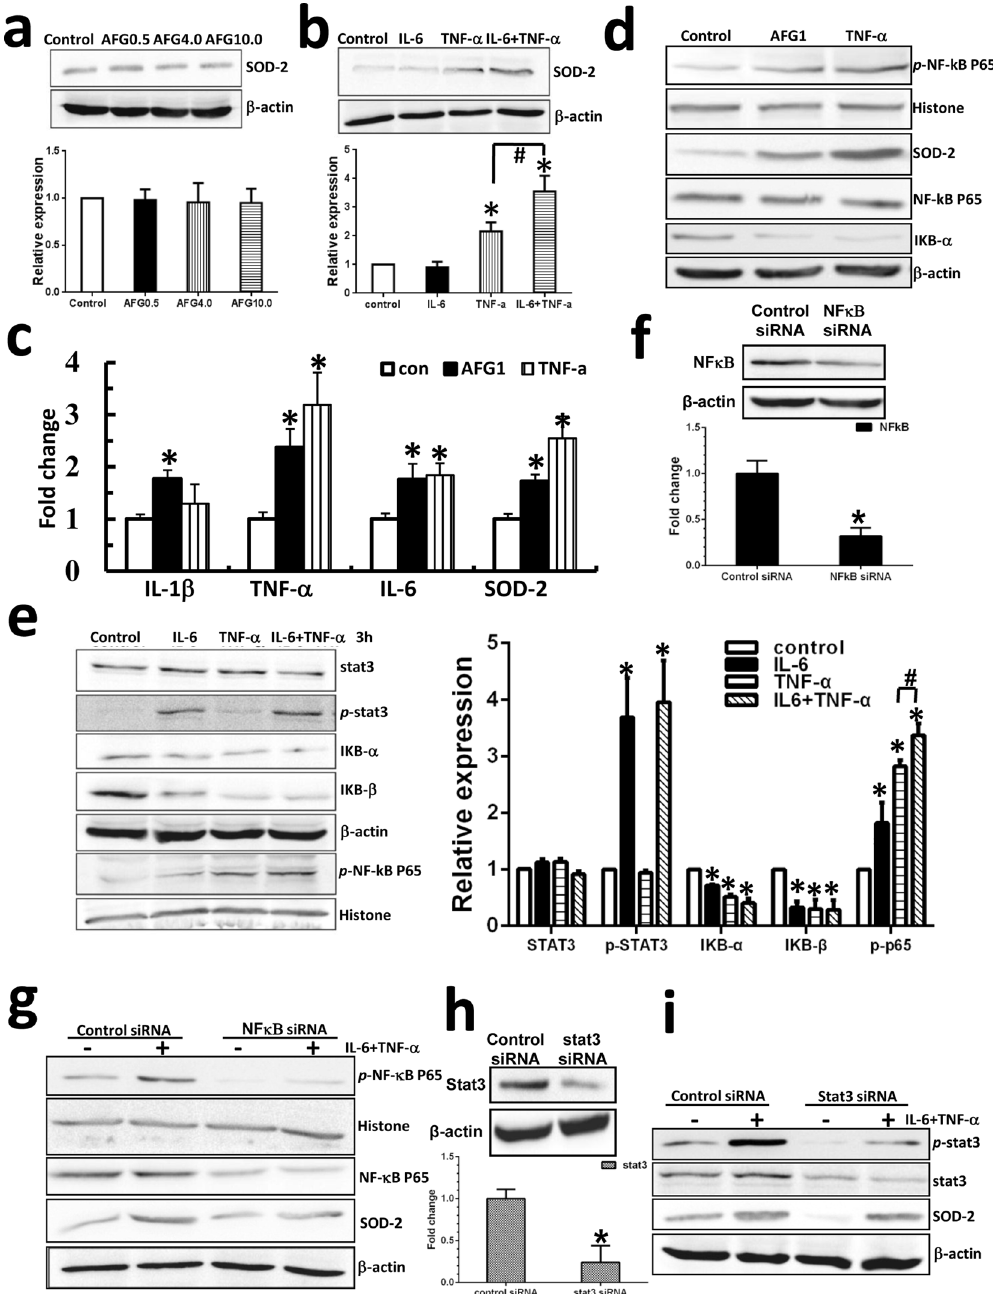
Figure 4. Up-regulation of SOD-2 in cancer cells is dependent on inflammation-activated NF- κ B pathway. To mimic an AFG 1 -induced tumor-associated inflammatory response in vitro , we treated human lung adenocarcinoma cell line A549 and human macrophage cell line M Φ -THP-1 with AFG 1 and/or TNF- α and IL-6. ( a , b ) After AFG 1 or TNF- α and IL-6 treatment for 24 h, the expression of SOD-2 in A549 cell was detected by Western blot. Data was shown as mean ± SD (three experiments, * p < 0.05, compared to control group). ( c ) M Φ -THP-1 cells were treated with AFG 1 or TNF- α for 24 h, and the expression of TNF- α , IL-6, IL-1 and SOD-2 at mRNA level were determined by real-time PCR. Data was shown as mean ± SD (three experiments, * p < 0.05, compared to control group). ( d ) After AFG 1 or TNF- α treatment for 24 h, the expression of SOD-2 as well as the activation of NF- κ B pathway in M Φ -THP-1 cells was measured by Western blot. ( e ) A549 cells were treated with TNF- α , IL-6, or TNF- α plus IL-6 for 3 hours, and the activation of NF- κ B and STAT3 pathways was measured by Western blot. Data was shown as mean ± SD (three experiments, * p < 0.05, compared to control group, # p < 0.05, compared to TNF- α alone). The expression of NF- κ B or STAT3 at mRNA and protein level was significant inhibited after transfection with NF- κ B siRNA ( f ) or STAT3 siRNA ( h ) in A549 cells. After 24 h of TNF- α plus IL-6 treatment in A549 cells tansfected with NF- κ B siRNA ( g ) or STAT3 siRNA ( i ), the expression of SOD-2 was detected by Western